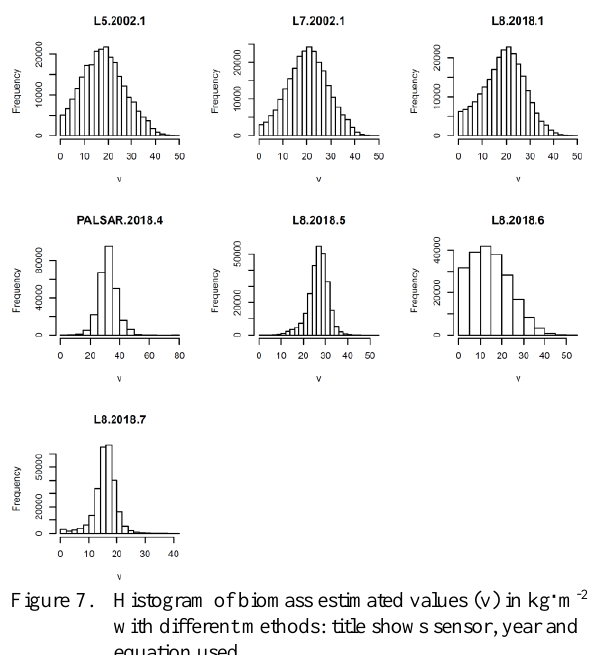
Figure 7. Histogram of biomass estimated values (v) in kg · m -2 with different methods: title shows sensor, year and equation used.